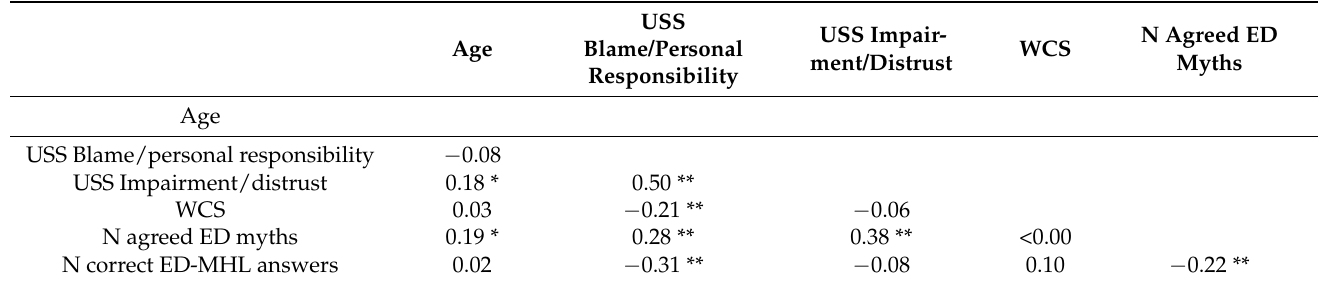
Table 4. Correlations between USS scales Blame/responsibility and Impairment/distrust, WCS, ED Myths Score, and correct answers to ED-MHL statements. USS N Agreed USS Impair- WCS Age Blame/Personal ment/Distrust Responsibility